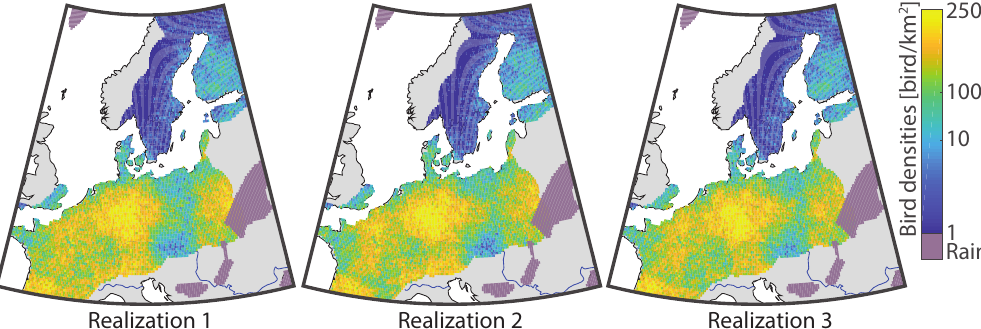
Figure 6. Snapshot of three different realizations showing peak migration (4 October 2016 21:00 UTC). The total number of birds in the air for these realizations was 125, 126, and 122 million, respectively. Comparing the similarities and differences of bird density patterns among the realizations illustrates the variability allowed by the stochastic model. The texture of these realizations is more coherent with the observations than the smooth estimation map in Figure